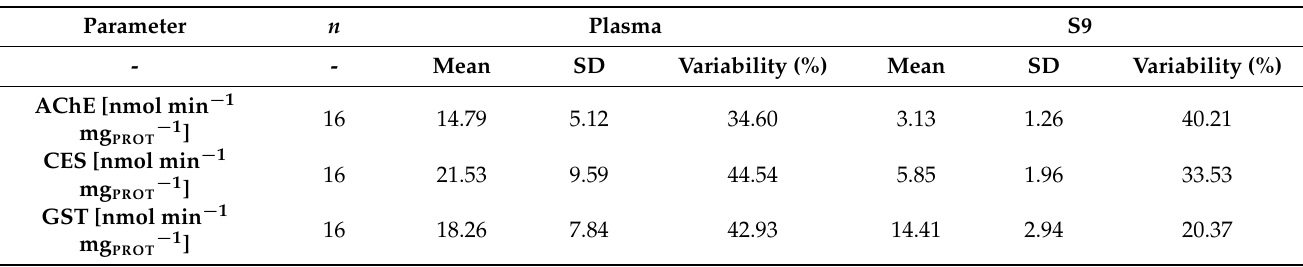
Table 1. Results (sample size ( n ), mean ± SD, and variability) of the enzymatic parameters and fluorescent dyes measured in plasma and S9 of white stork ( C. ciconia )